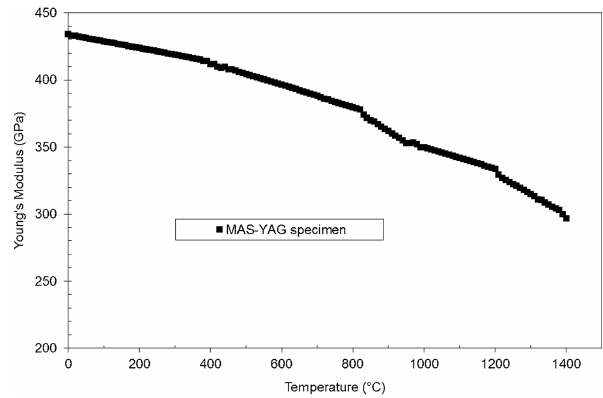
Figure 5: Young ’ s modulus at varying temperatures for directionally solidified eutectic ceramic MgAl 2 O 4 -Y 3 Al 5 O 12 .